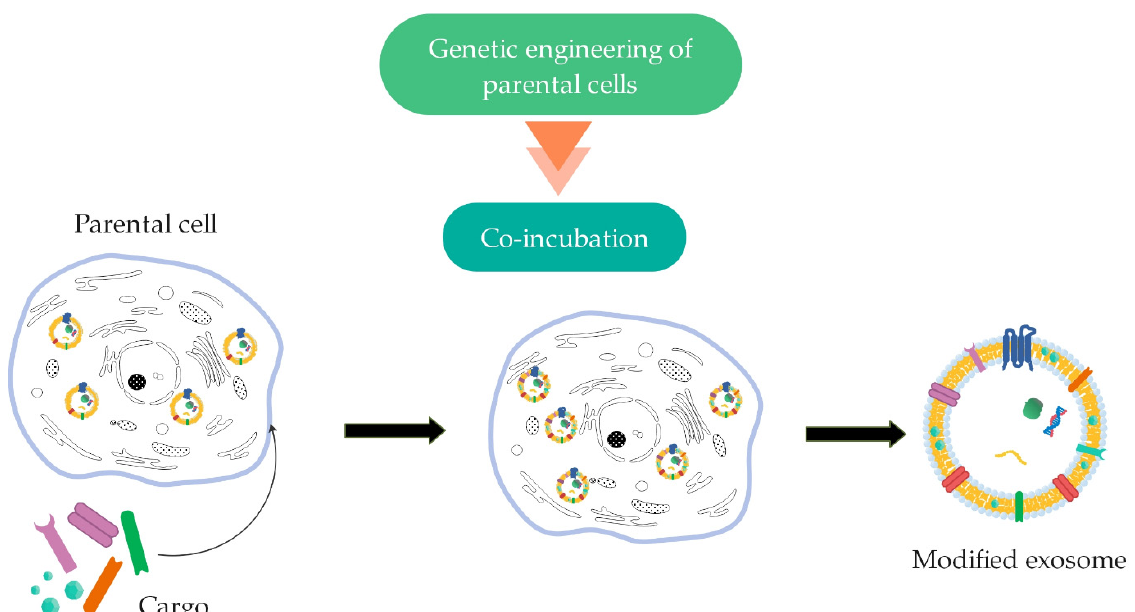
Figure 6. Genetic engineering of parental cells for surface modification of exosomes by the method of co-incubation (summarized from [11,16]).